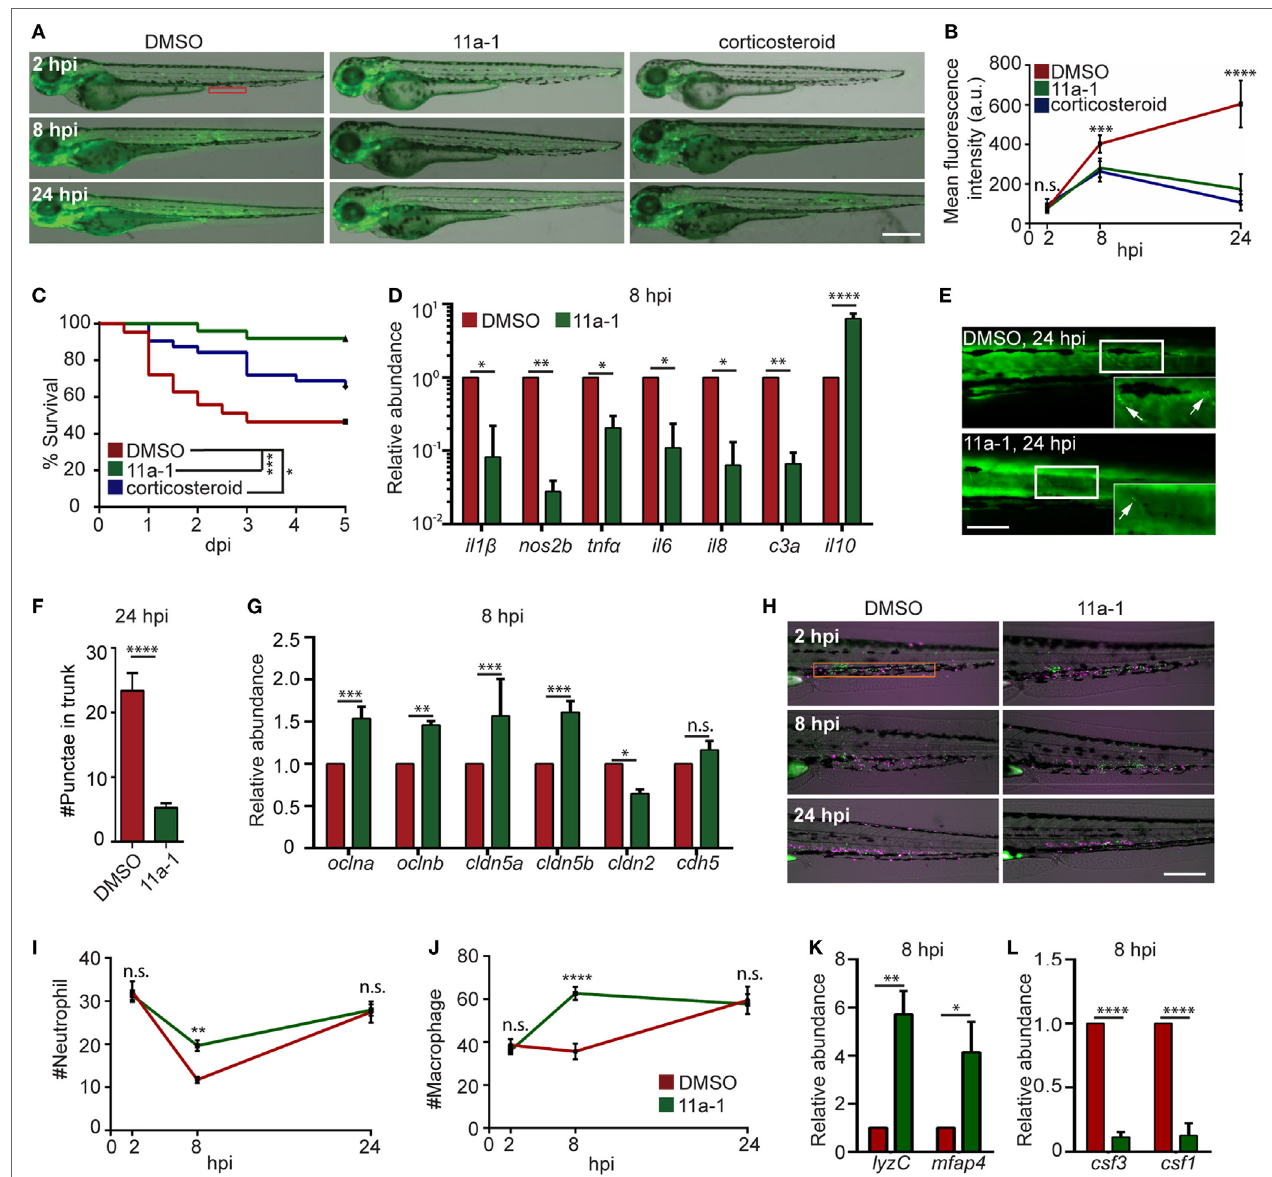
FigUre 7 | Shp2 inhibitor reduces lipopolysaccharide (LPS)-induced systemic inflammation and mortality. (a,B) Zebra fish embryos of Tg(NF: κ B:GFP) were treated with DMSO, Shp2 inhibitor (11a-1), or corticosteroids and injected with LPS. Representative images (a) and quantification (B) of the GFP intensity in the indicated region. Scale bar: 500 µm. Results are presented as mean ± SD (D) ( n = 3 independent experiments with over 20 larvae each/experiment). *** p < 0.001, ****